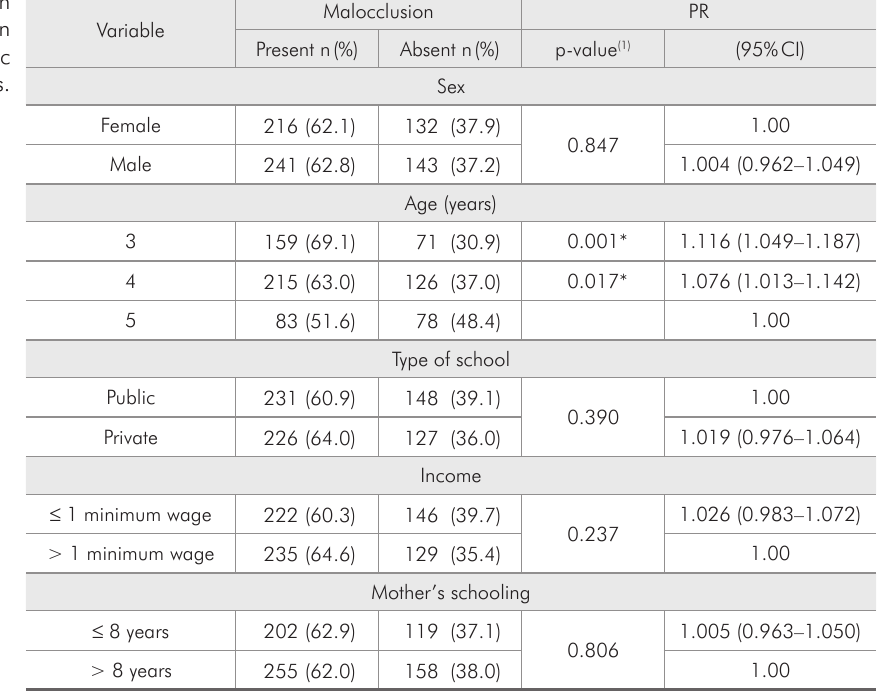
Table 3 - Bivariate Poisson regression of malocclusion and socioeconomic